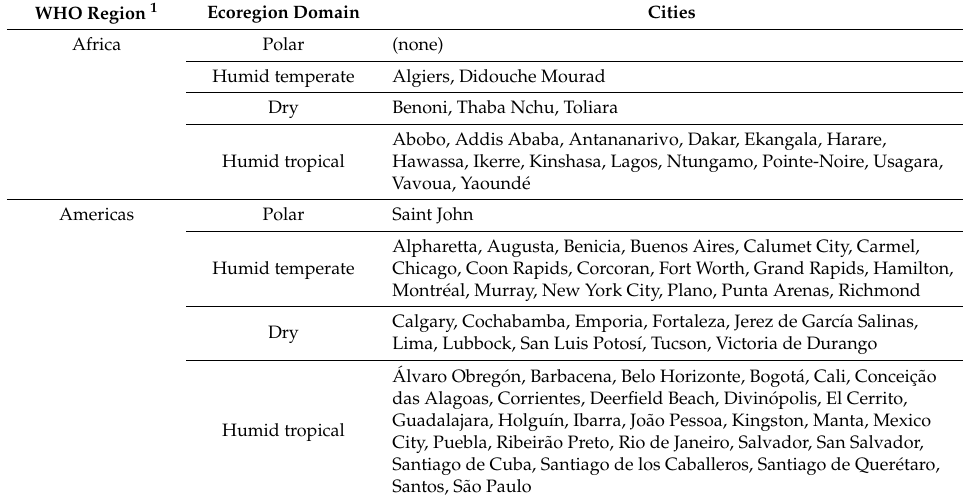
Table 1. List of SHUE cities by WHO region and Bailey’s ecoregion